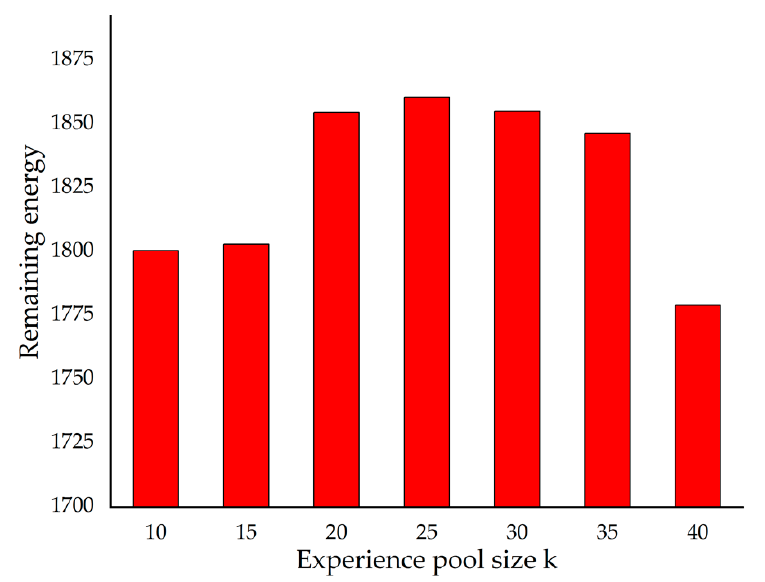
Figure 10. The relation between energy remained and k.